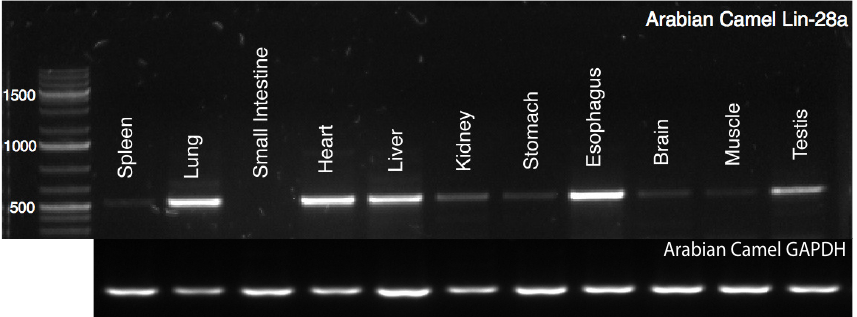
Figure 1. Agarose gel (1.2%) electrophoresis of PCR products for cLin-28 mRNA, 1500 bp DNA molecular weight marker was